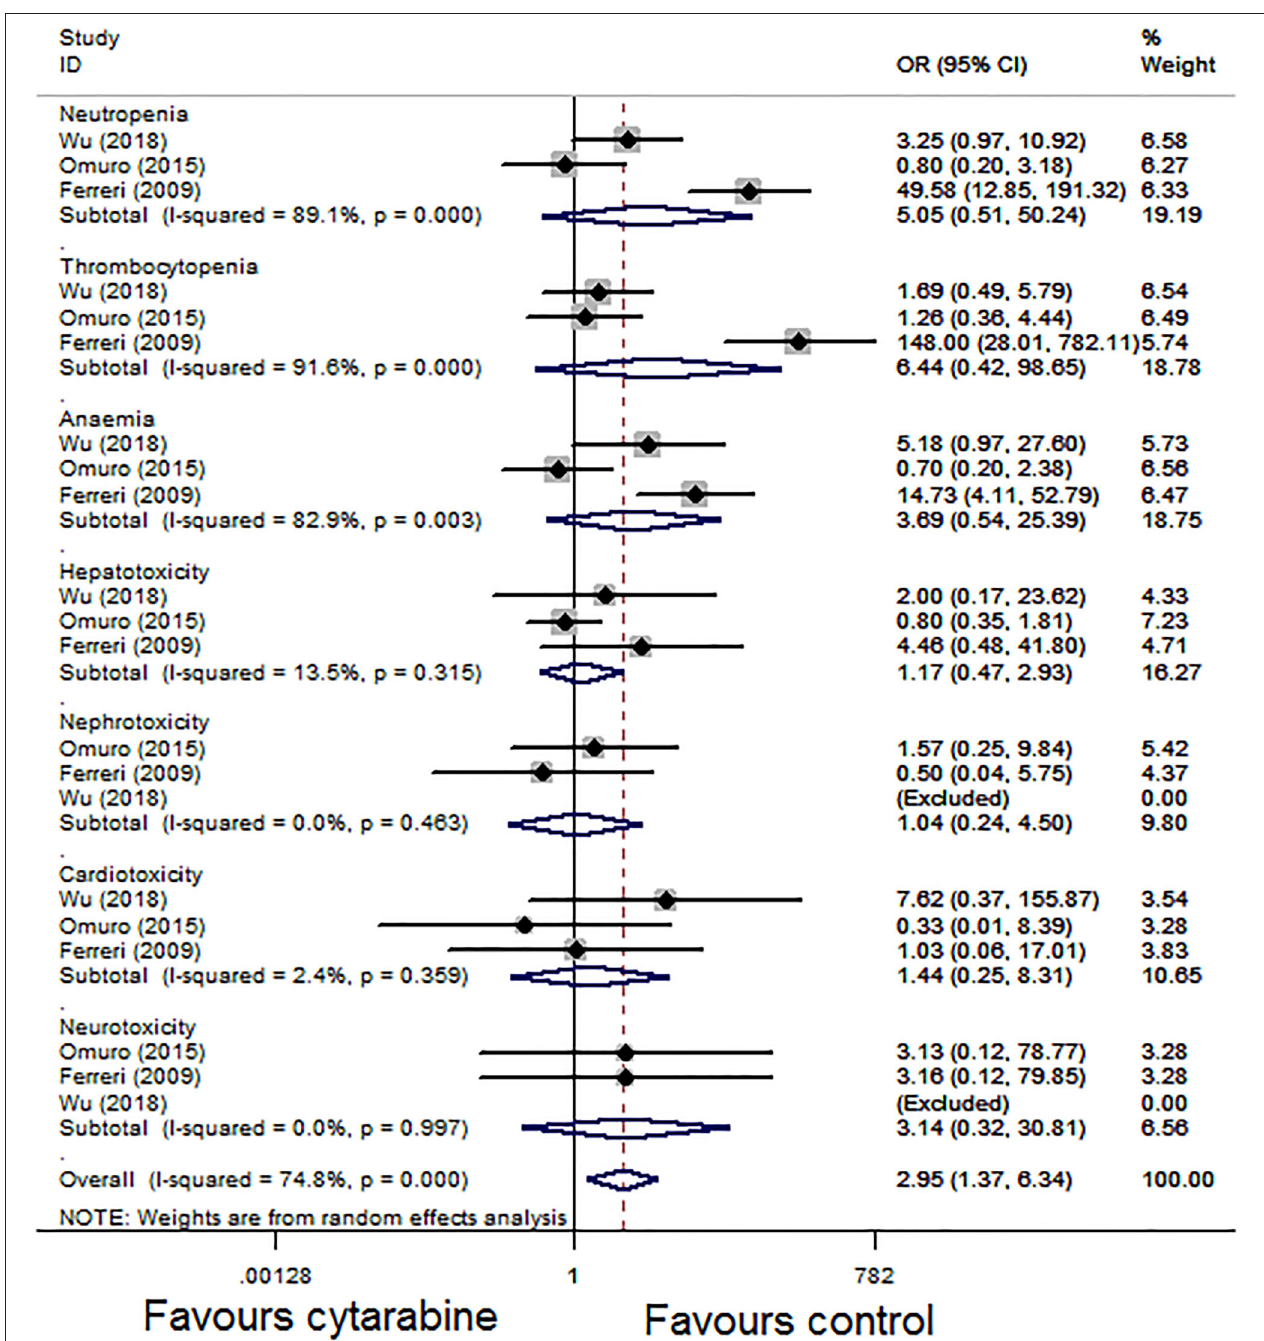
FIGURE 4 | Forest plot of grade 3–4 toxicities for treatment with the cytarabine group vs. the cytarabine-free group (fixed effect model). OR is the effect size.